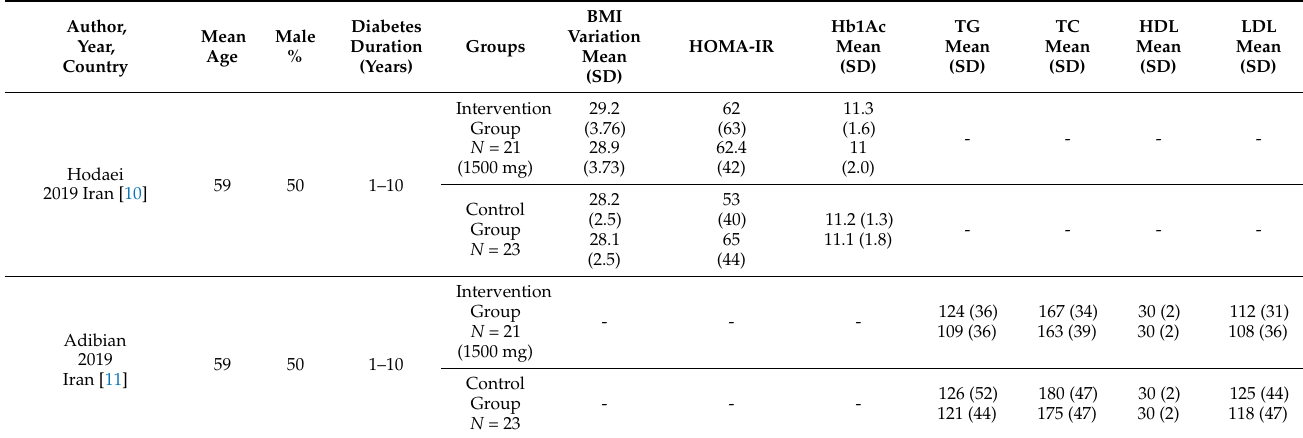
Table 1. The characteristics of included studies, according to intervention group (curcumins) and control groups (placebo) and results for each selected